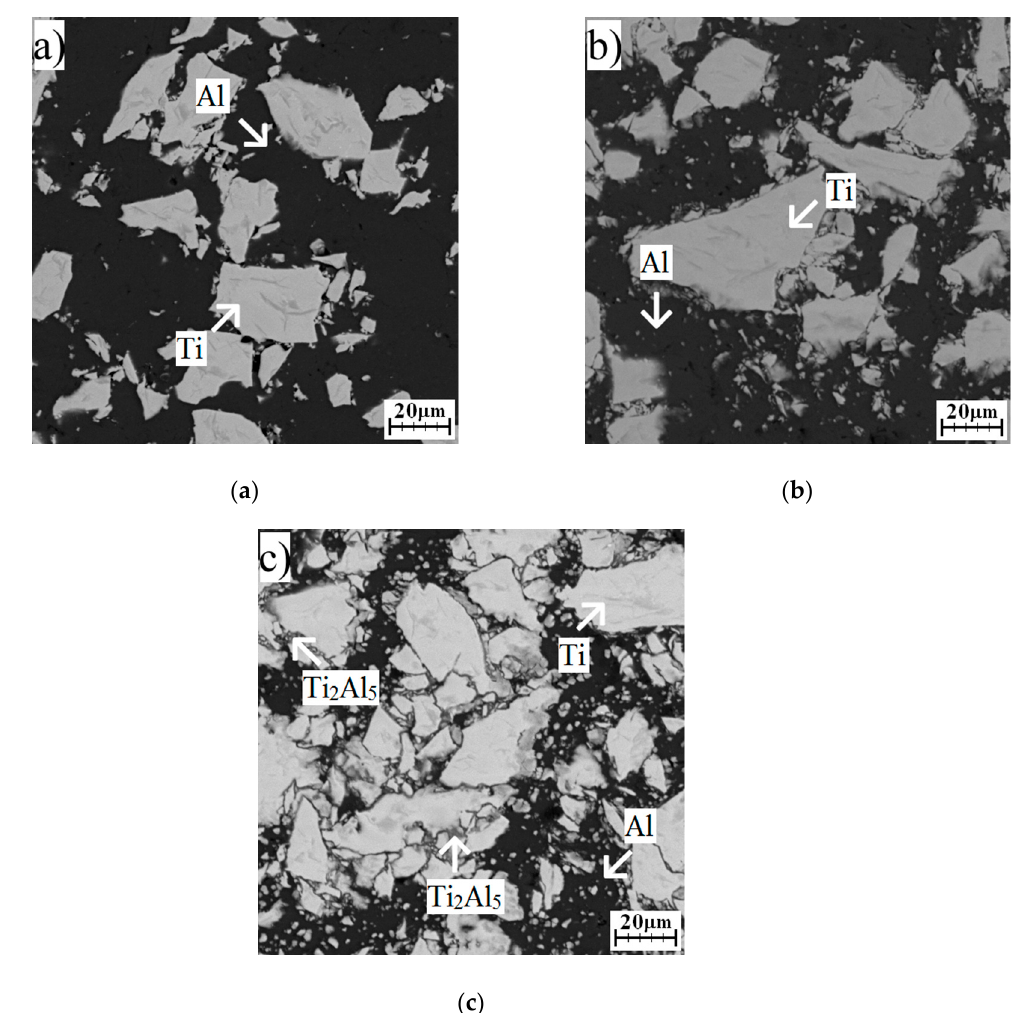
Molecules 2020 , 25 , x FOR PEER REVIEW Figure 4. The microstructure of TiAl63 alloys annealed at 450 ◦ C for ( a ) 8 h, ( b ) 24 h, and ( c ) 48 h. Figure 4. The microstructure of TiAl63 alloys annealed at 450 °C for ( a ) 8 h, ( b ) 24 h, and ( c ) 48 h.